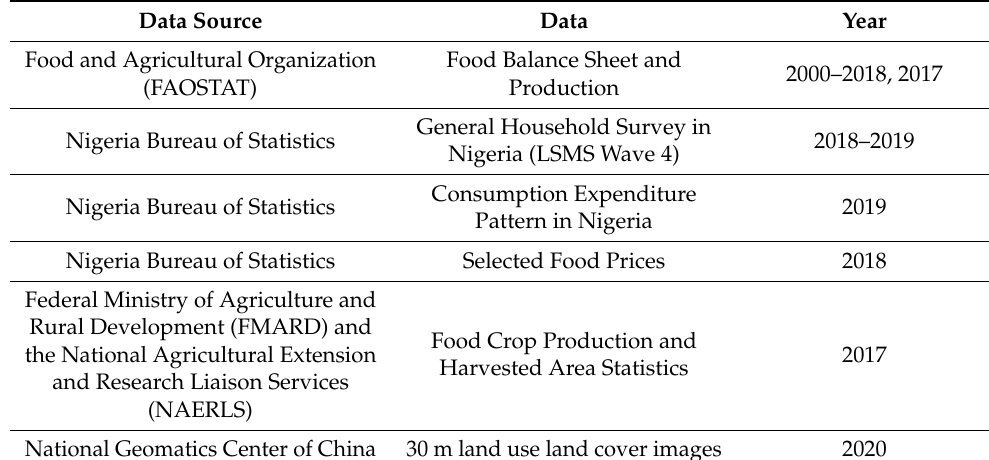
Table 2. Summary of the data source